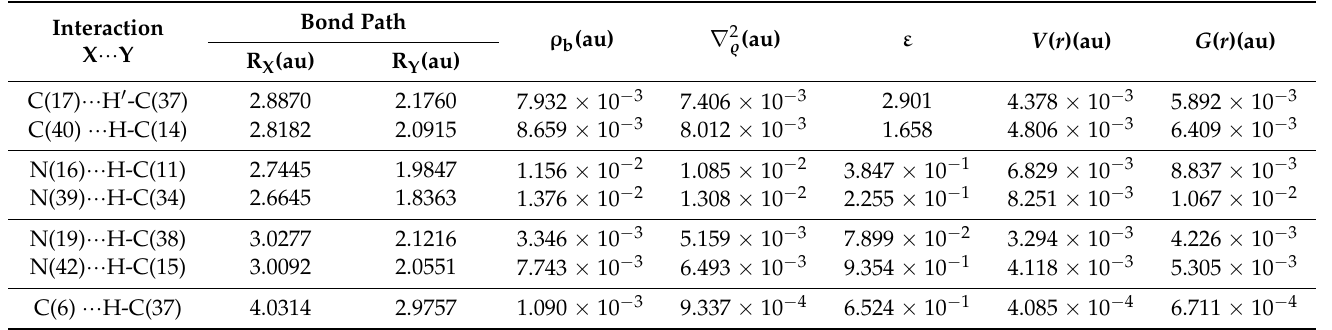
Table 2. Topological parameters 1 for closed-shell intramolecular BCPs in crystalline molecular unit 8 . Line separations are included for a better comparison between interactions of the same